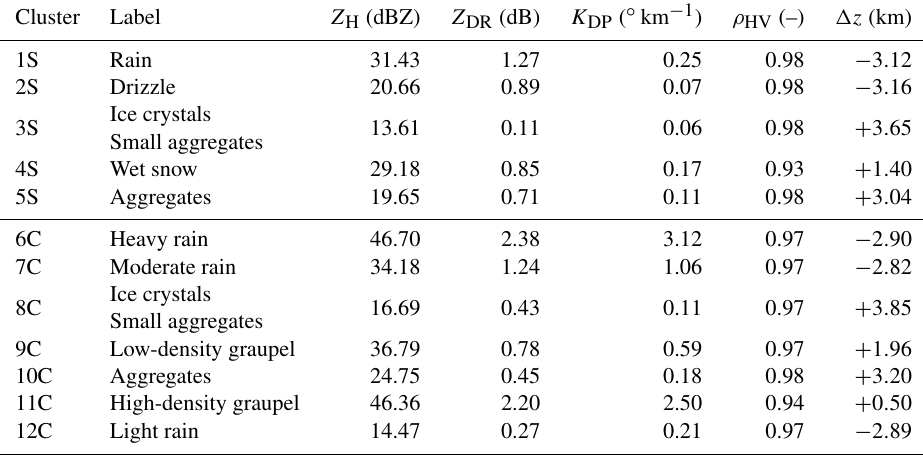
Table A2. Cluster centroids for the dry season.